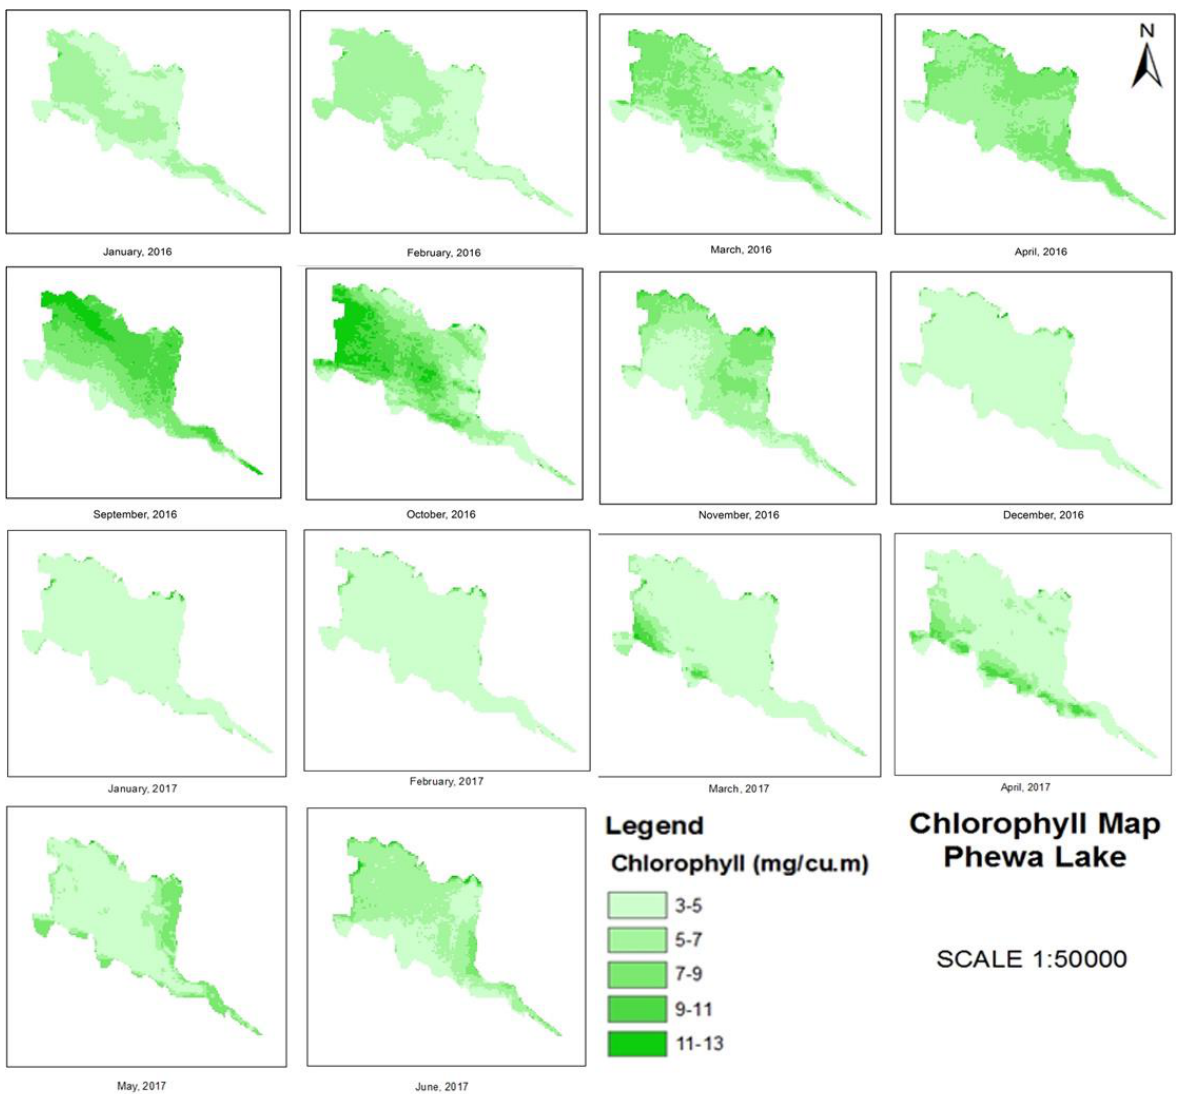
Figure 3. Chl-a maps of Phewa Lake using band combination and quadratic regression for different months associated with it. Monthly Chl-a maps of Phewa Lake from the January 2016